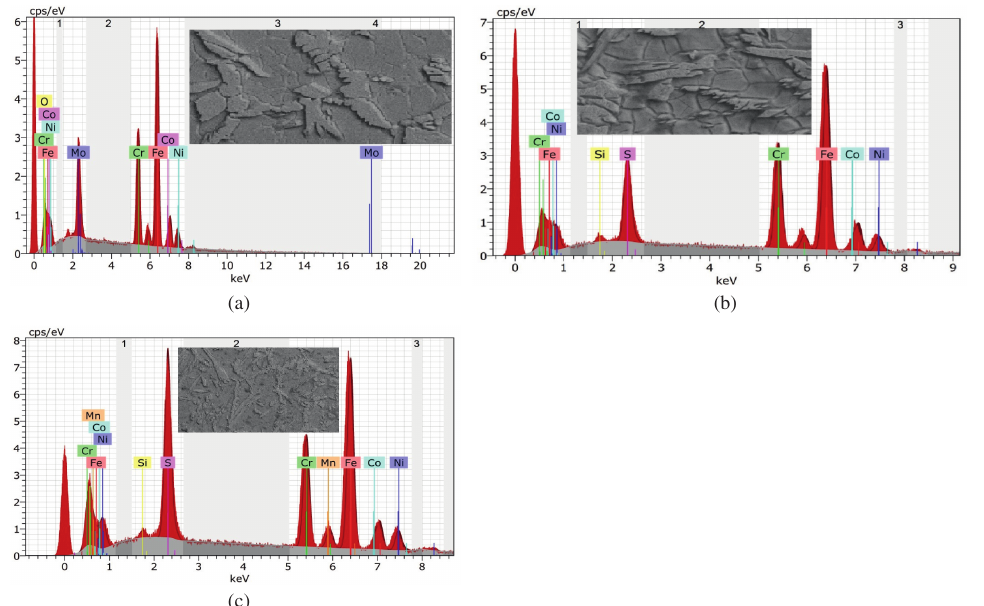
Figure 10: EDX analysis results of duplex SS 2205 weld metal at three different locations (a) weld metal (b) Heat affected zone and (c) weld